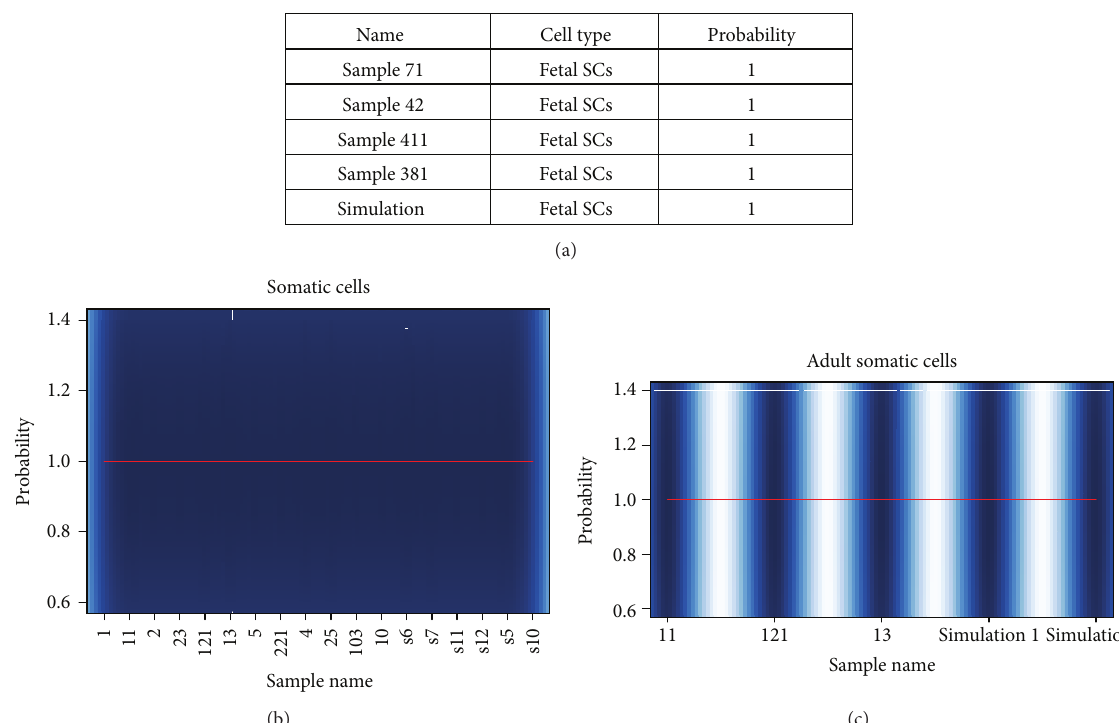
Figure 3: Reporting result. WCTDS reports its results in two file formats, plain text file and figure file in pdf format. (a) A partial text file shows the text file format. (b) An example of the figure format of cell type result. Color represents data distribution density. (c) An example of subtype